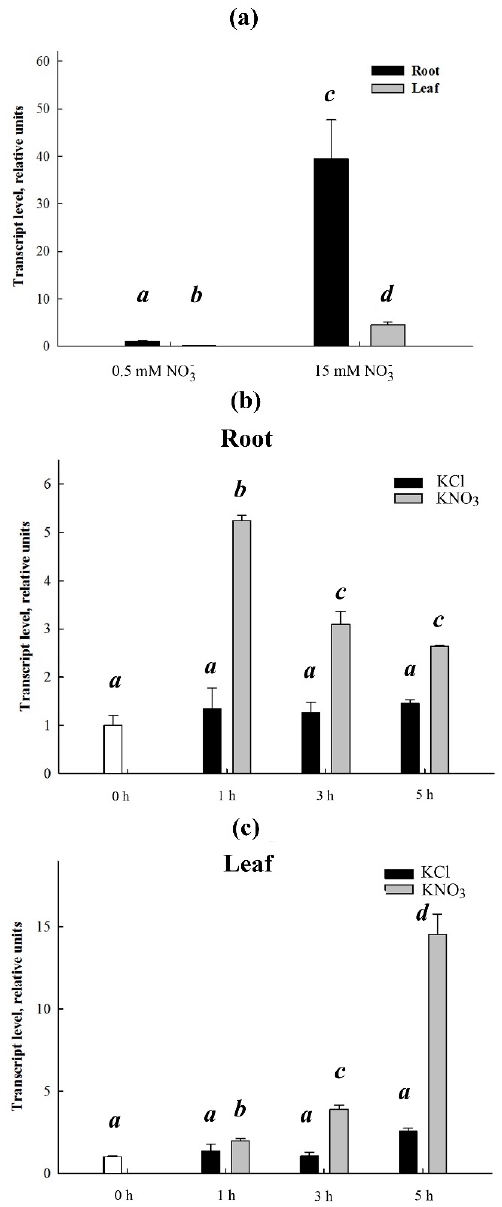
Figure 6. Effect of nitrate in the growth medium on expression of SaCLCa2 in Suaeda altissima . ( a ) Relative transcript abundances of SaCLCa2 in roots (dark bars) and leaves (light bars) of plants grown at nitrate deficiency (0.5 mM) or sufficient supply (15 mM) of nitrate under long-term experiments. Fast dynamics of relative abundance of SaCLCa2 transcripts in roots ( b ) and leaves ( c ) of plants grown on nitrate deficiency (0.5 mM) medium after addition to the medium of KNO 3 (light bars) or, as a control, KCl (dark bars) up to the final concentration of 5 mM. Transcript abundance levels are taken as 1 at zero time-points (white bars) when 5 mM of KCl or KNO 3 was added. Data shown are means ± SE from three independent experiments. Each of them was performed in three analytical replicates. Bars with different letters are significantly different at p < 0.05.